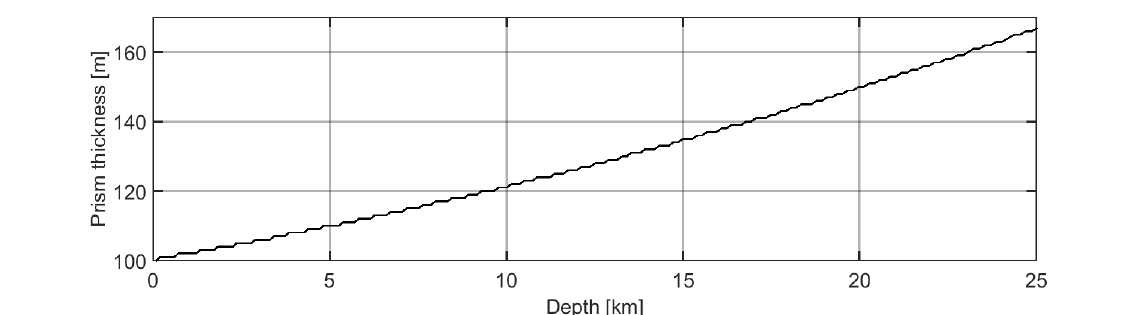
Figure 7. Prism thickness as a function of